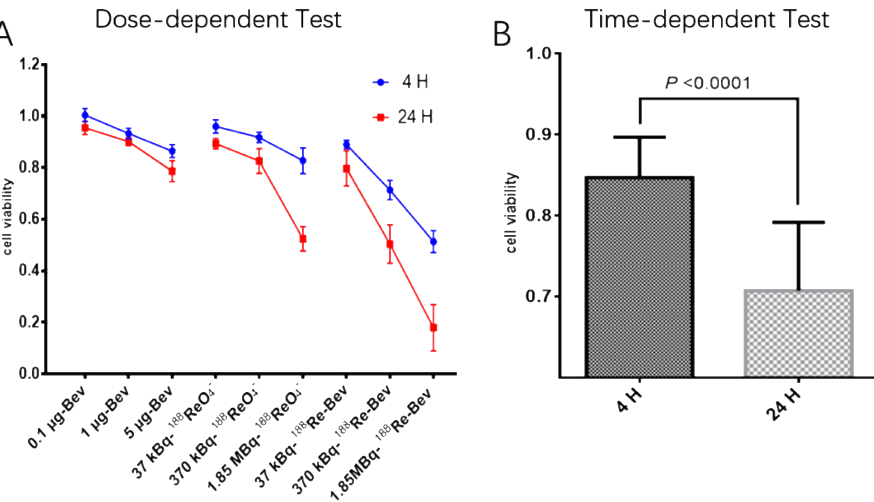
Figure 2. Cell viability is in a radioactive- and time-dependent manner. ( A ) Dose-dependent test: changes of cell viability after incubation with fresh medium containing bevacizumab at various concentrations, free 188 Re and 188 Re-bevacizumab; ( B ) Time-dependent test: compared average cell viability of all treated group (bevacizumab, free 188 Re and 188 Re-bevacizumab) at 4 h and at 24 h.